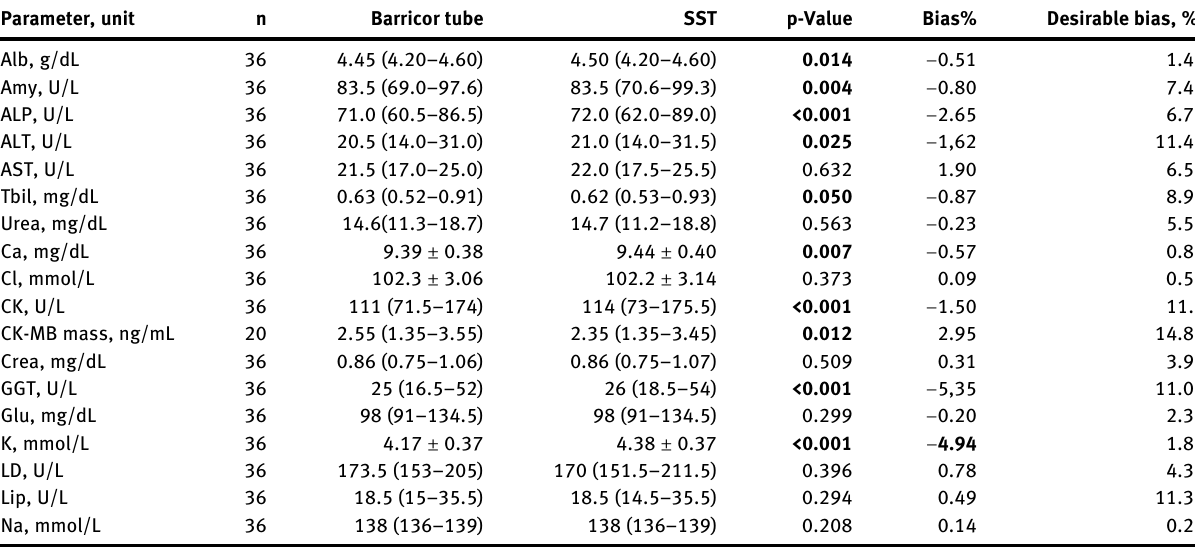
Table  : Descriptive statistics and comparison results for Barricor tube and SST in outpatient clinic patients. Parameter,